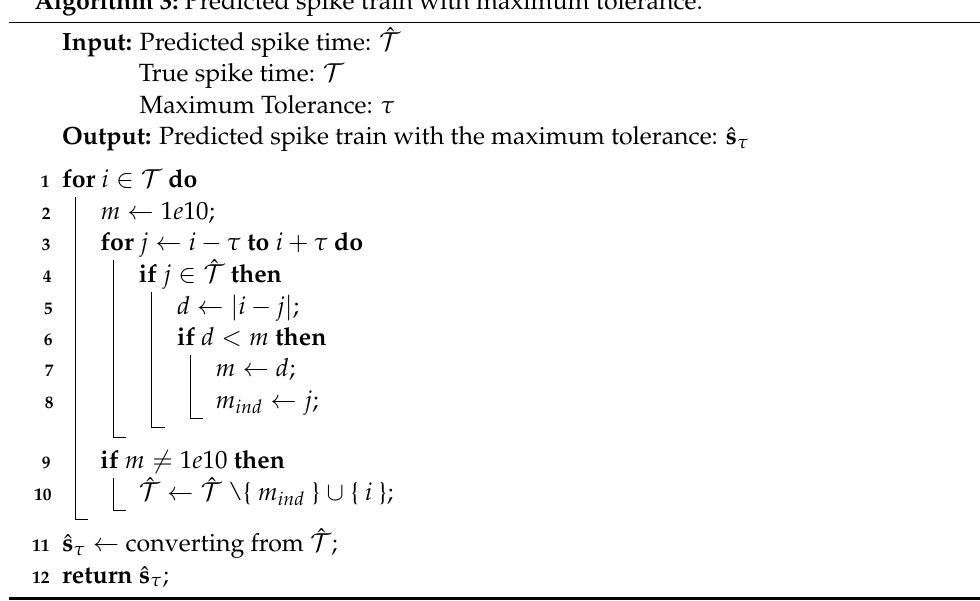
Algorithm 3: Predicted spike train with maximum